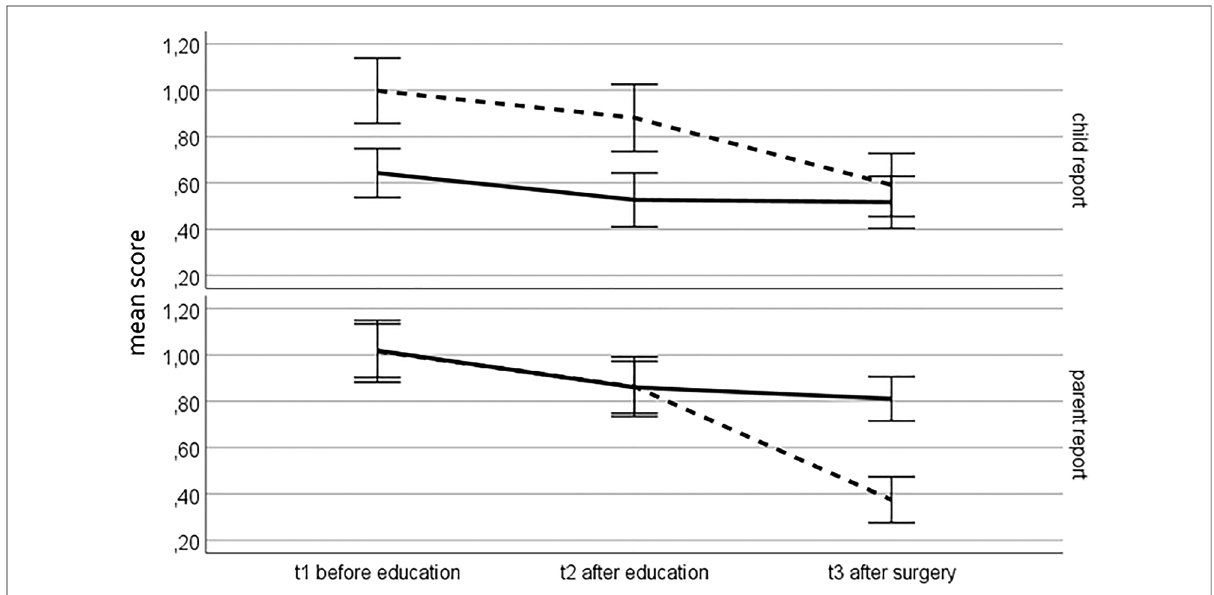
FIGURE 1 Course of surgery anxiety before (t1) and after (t2) intervention and after surgery (t3) according to the child report and parent report. Mean STOA- Sumscore (dash line) and Trait (solid line) with 95%-CI, normed on 0 – 3 (0=not at all, 1= slightly, 2=quite, 3=very)